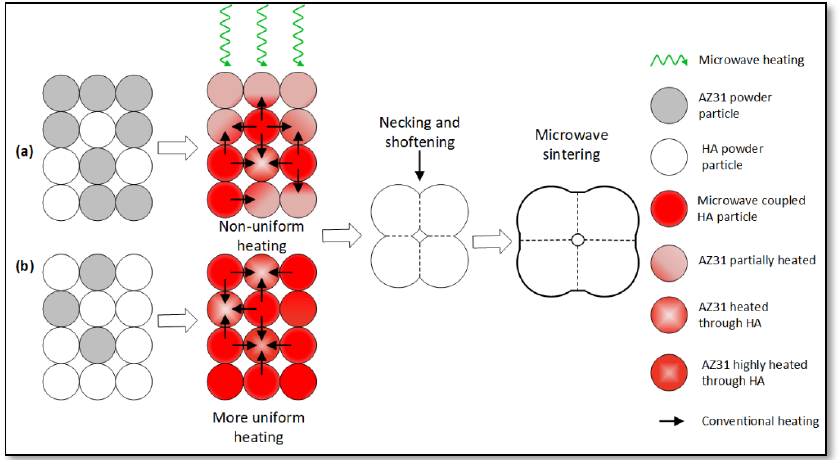
Figure 3. Microwave sintering mechanism and the interaction of microwave radiation with ( a ) AZ31 metal alloy and small amount of HA powder particles and ( b ) AZ31 metal alloy with large amount of HA powder particles.